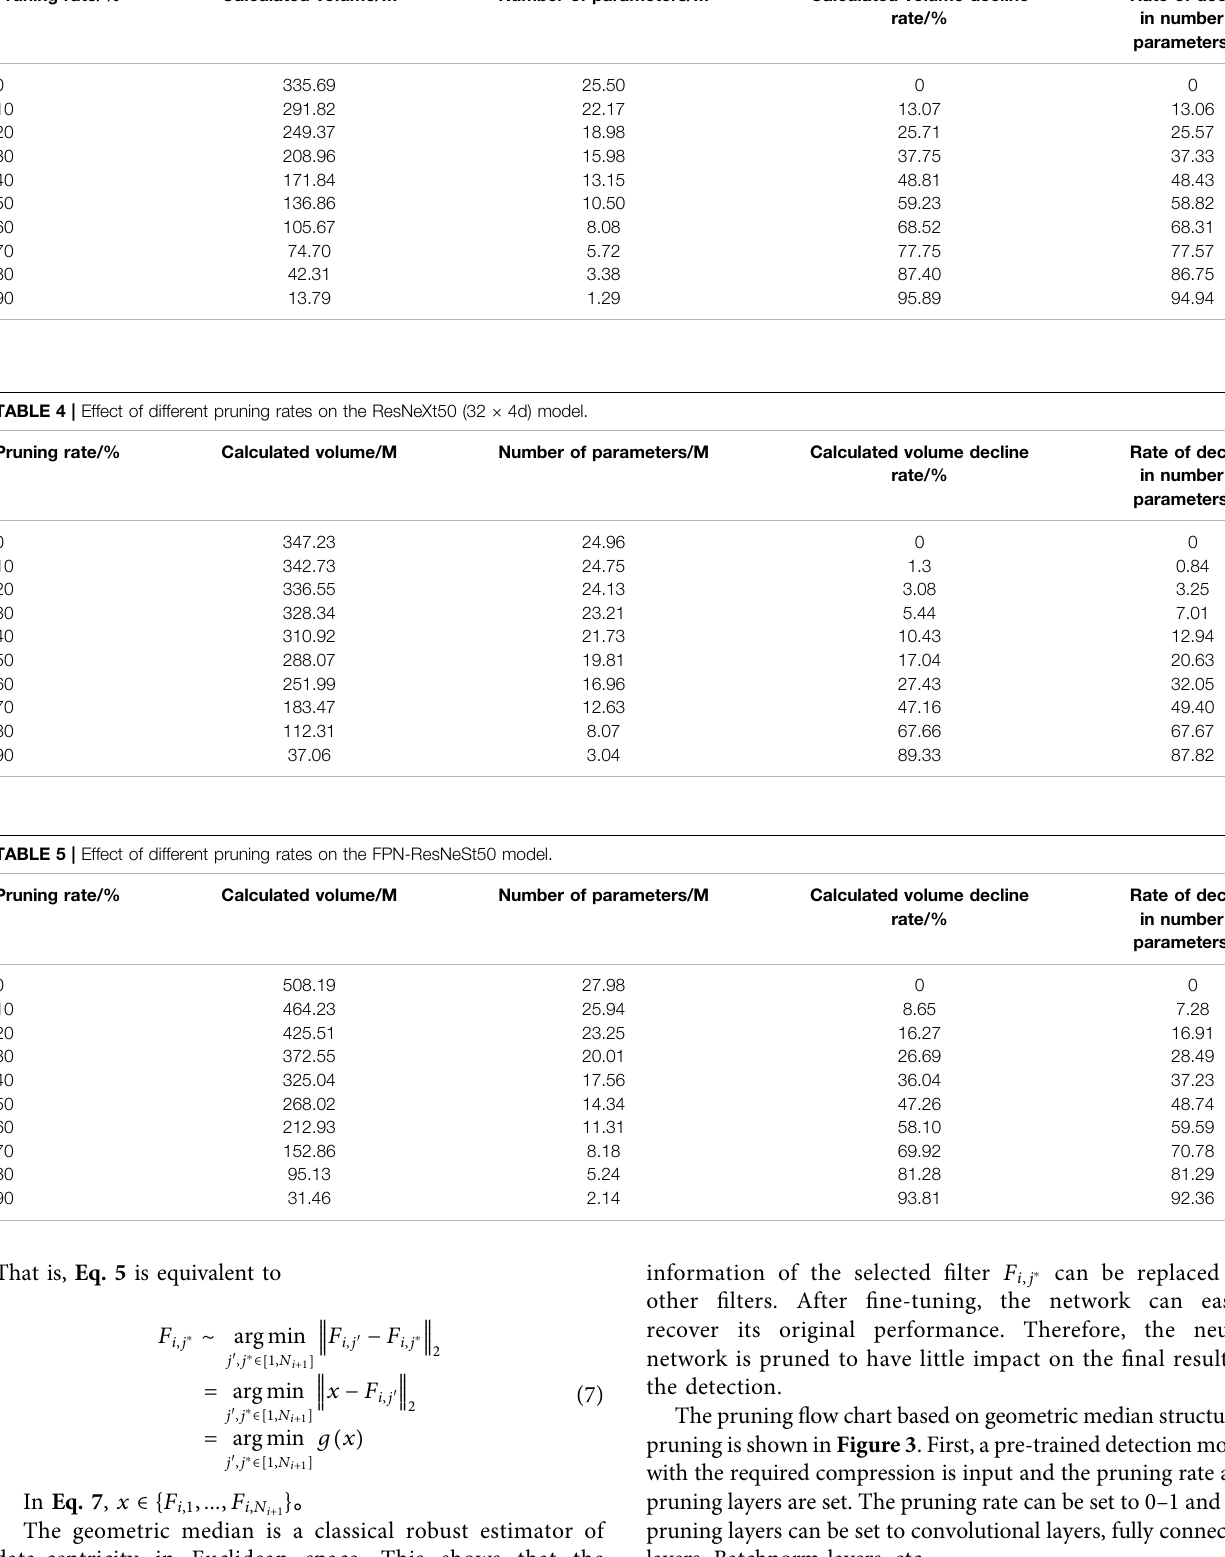
TABLE 3 | Effect of different pruning rates on the ResNet50 model. Pruning rate/%